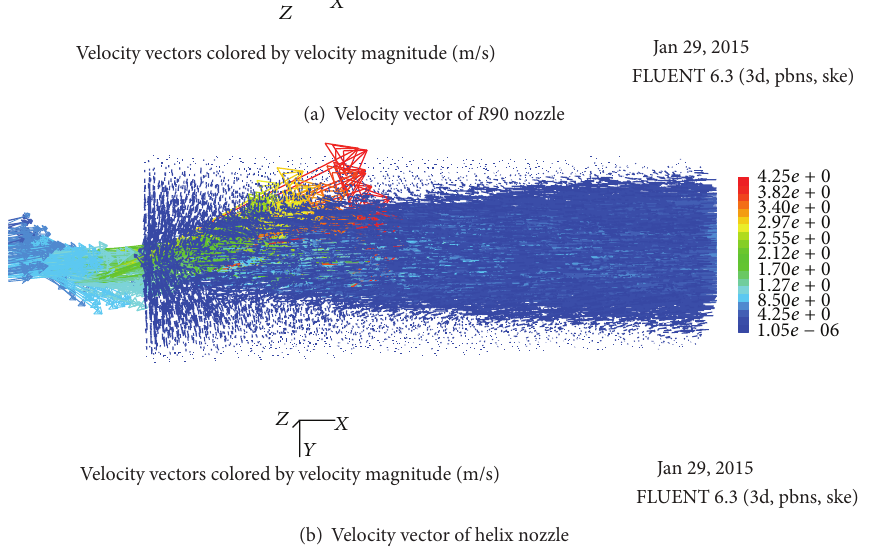
Figure 11: Comparison of velocity vectors of R 90 nozzle and helix